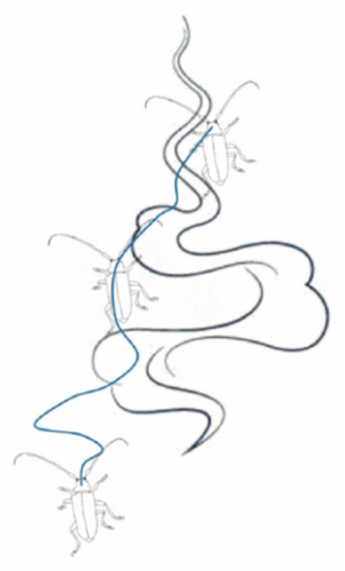
Figure 1. Schematic diagram of beetle movement